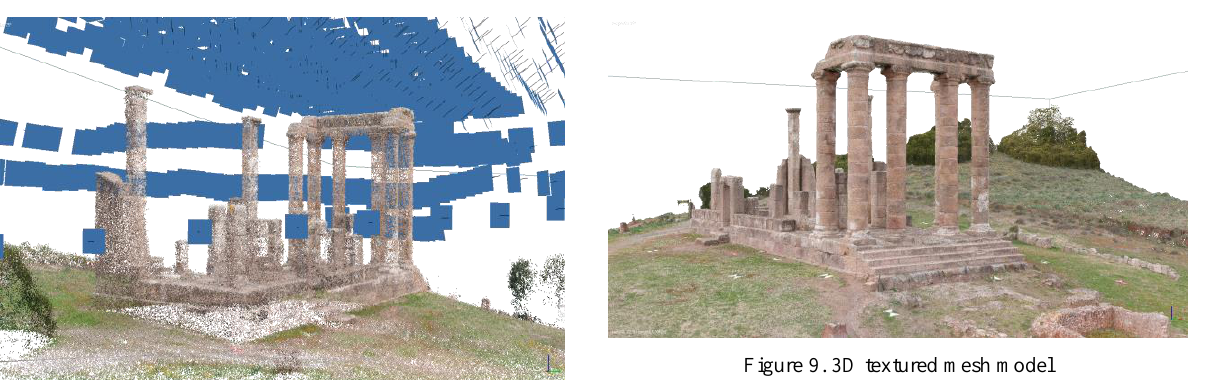
Figure 6. Dense cloud